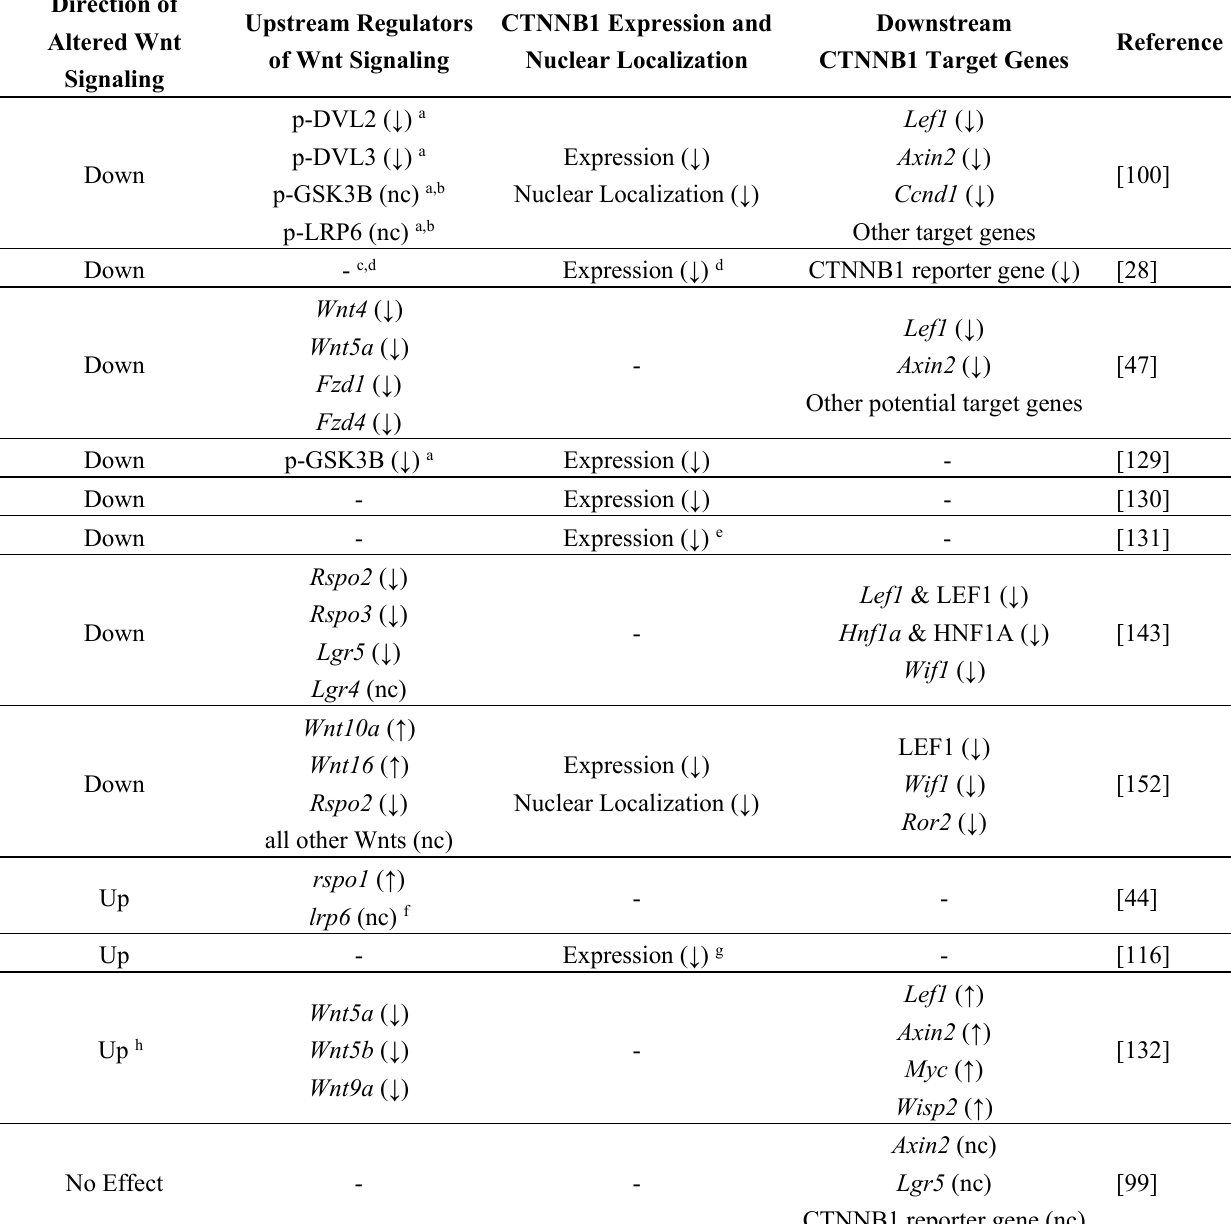
Table 2. Effects of Activated AHR on Canonical Wnt